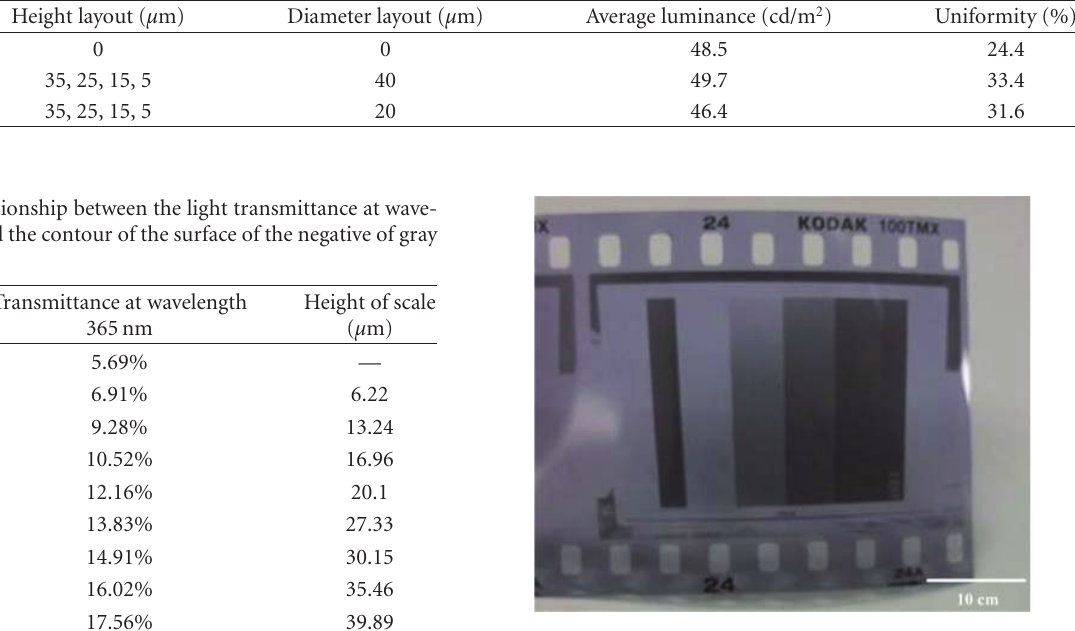
Figure 10: Homemade gray scale